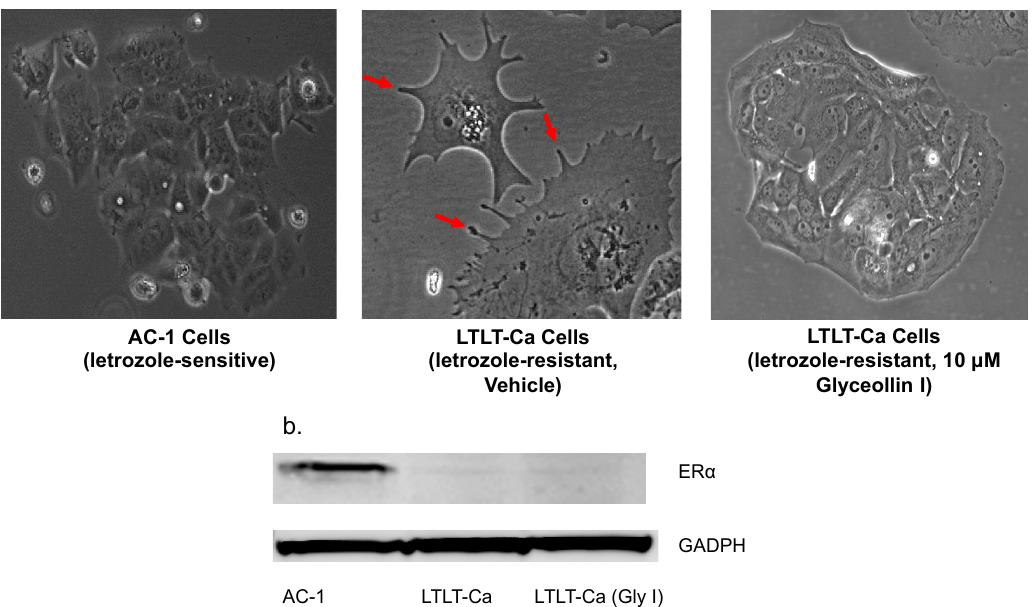
Figure 2. ( a ) Glyceollin I alters the cell morphology. The morphology of letrozole sensitive (AC-1) cells were compared to that of LTLT-Ca cells ± 10 μ M glyceollin I. Cell images were captured by microscopy using Olympus BX41 at 10x magnification and red arrows indicate invadopodia; ( b ) Glyceollin I does not restore ER levels. AC-1, LTLT-Ca and LTLT-Ca cells treated with 10 μ M glyceollin I were assayed by immunoblot to examine the expression of ER α and GAPDH (loading control). Representative immunoblot depicts that AC-1 cells are positive for ER α , while LTLT-Ca cells ± 10 μ M glyceollin I express low ER α .